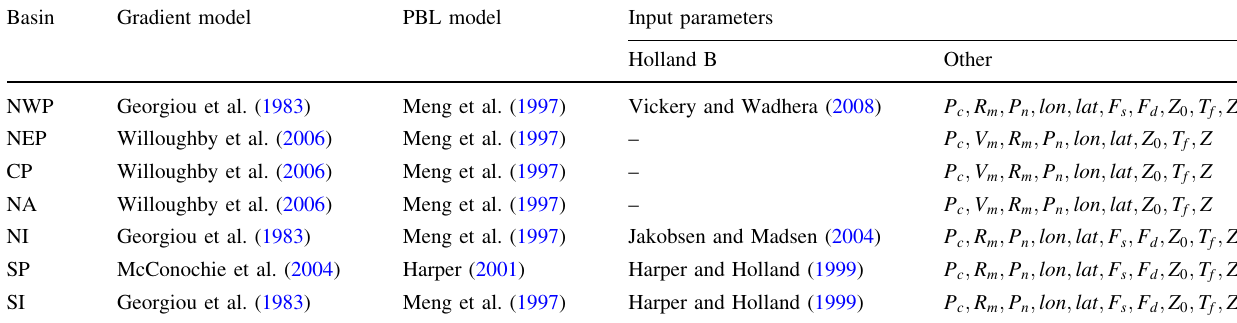
Table 1 Parametric wind field models for the seven basins and their key parameters